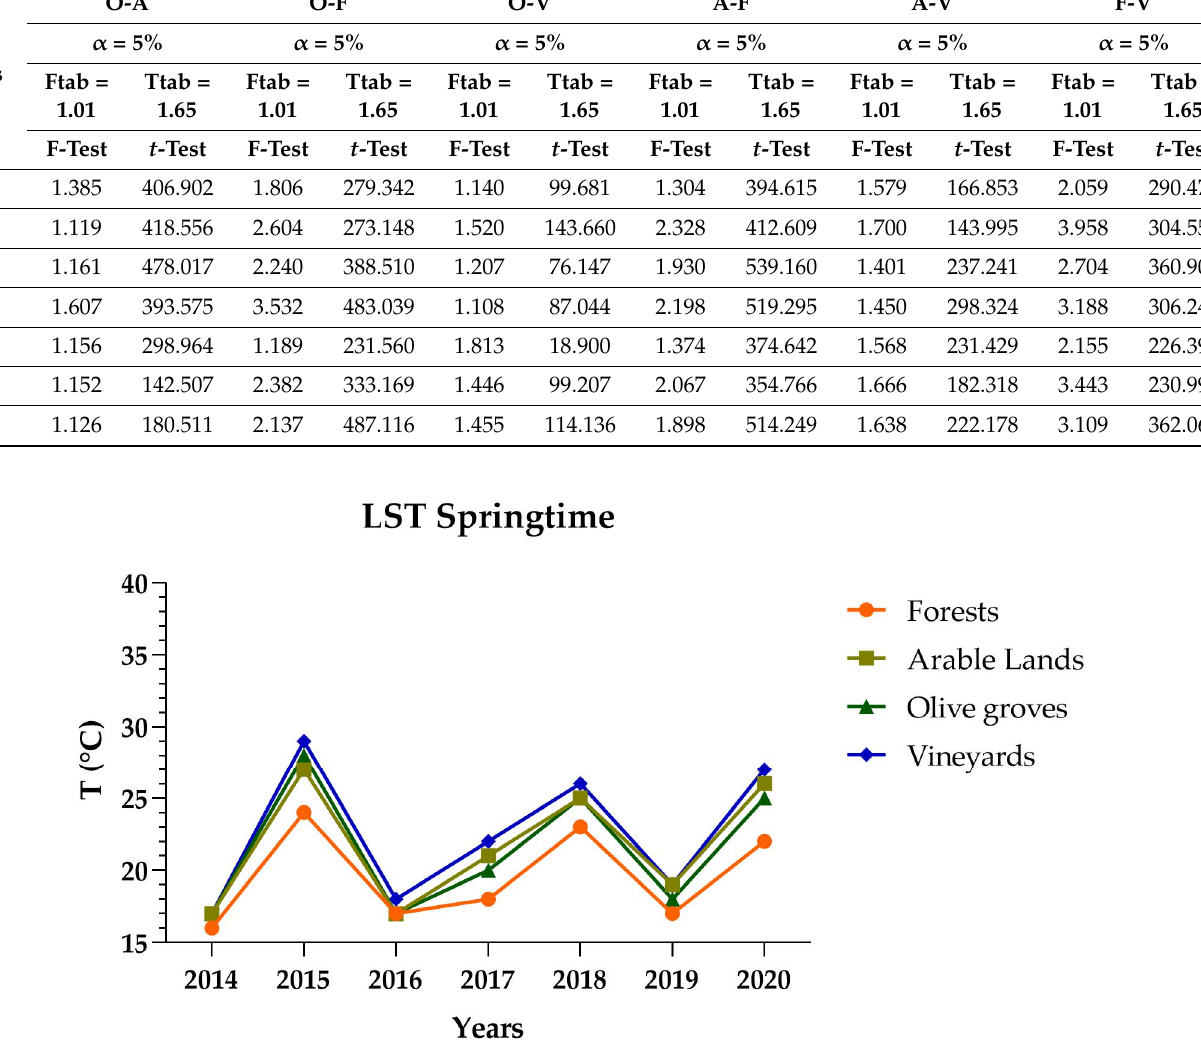
Figure 6. Average LST temperature for each type of land cover from 1 March to 10 May. The olive groves and farmland had close average LST values. In general, the differ- ences were less pronounced than in the summer. The Fisher test showed that the average LST for different land cover types for the different years belong to distributions with dif- ferent variance (Table 3), while the average values for the Student’s t test were statistically different. Indeed, in the tests the values were higher than the references tabulated to de- termine significance. Table 3. Fisher test and Student test to analyse the statistical differences among the land covers reported in Figure 6.